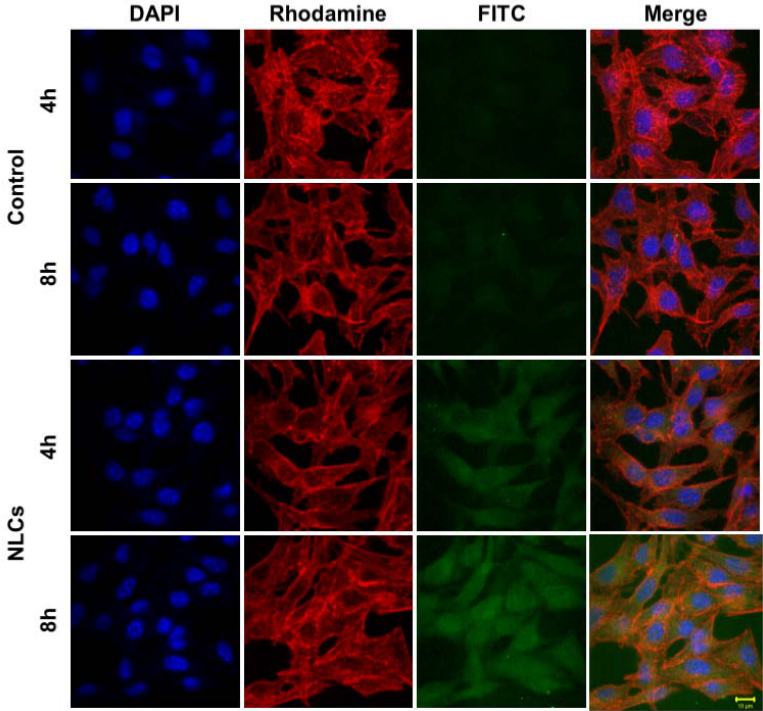
Figure 11. Fluorescent microscopic images of FITC solution and FITC-NLCs. Blue is the cell nuclei, red is the cell cytoplasm, and green is FITC. The diameter of the nucleus is 10 μm.